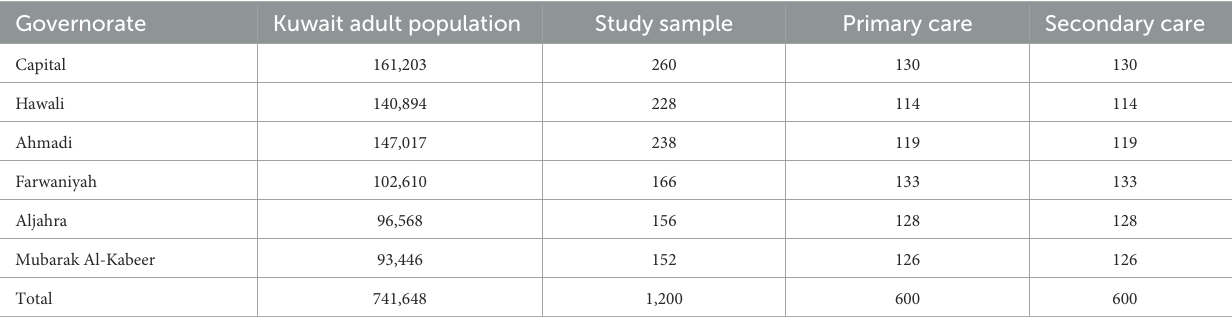
TABLE 1 Numbers of patients recruited from each